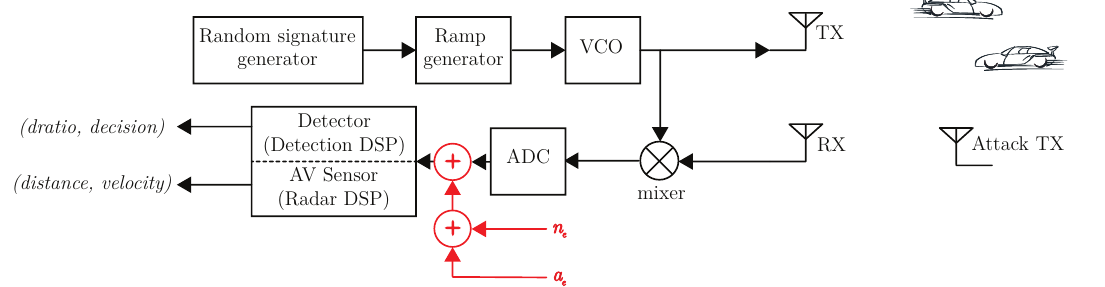
Figure 3. The proposed system block diagram. Signal path shown in red color represents mathematically equivalent effects of system noise and attack